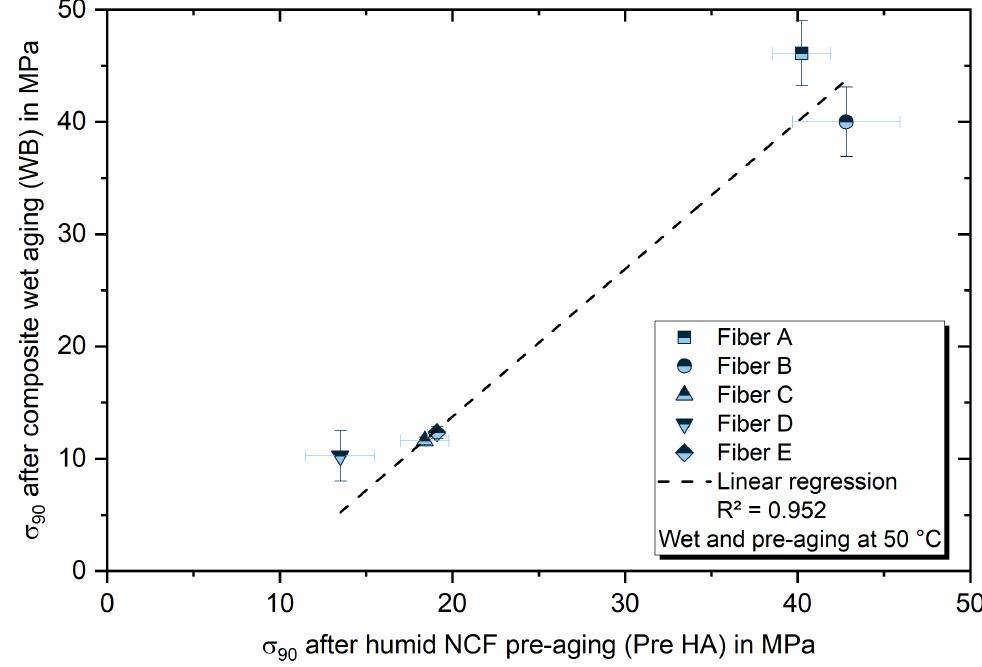
Figure 8. Correlation between transverse tensile strength after composite wet aging (WB) and NCF humid pre-aging (Pre Ha) for all investigated